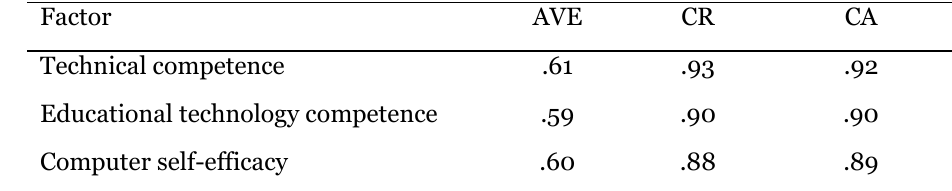
AVE, CR, and CA Scores of the Factors